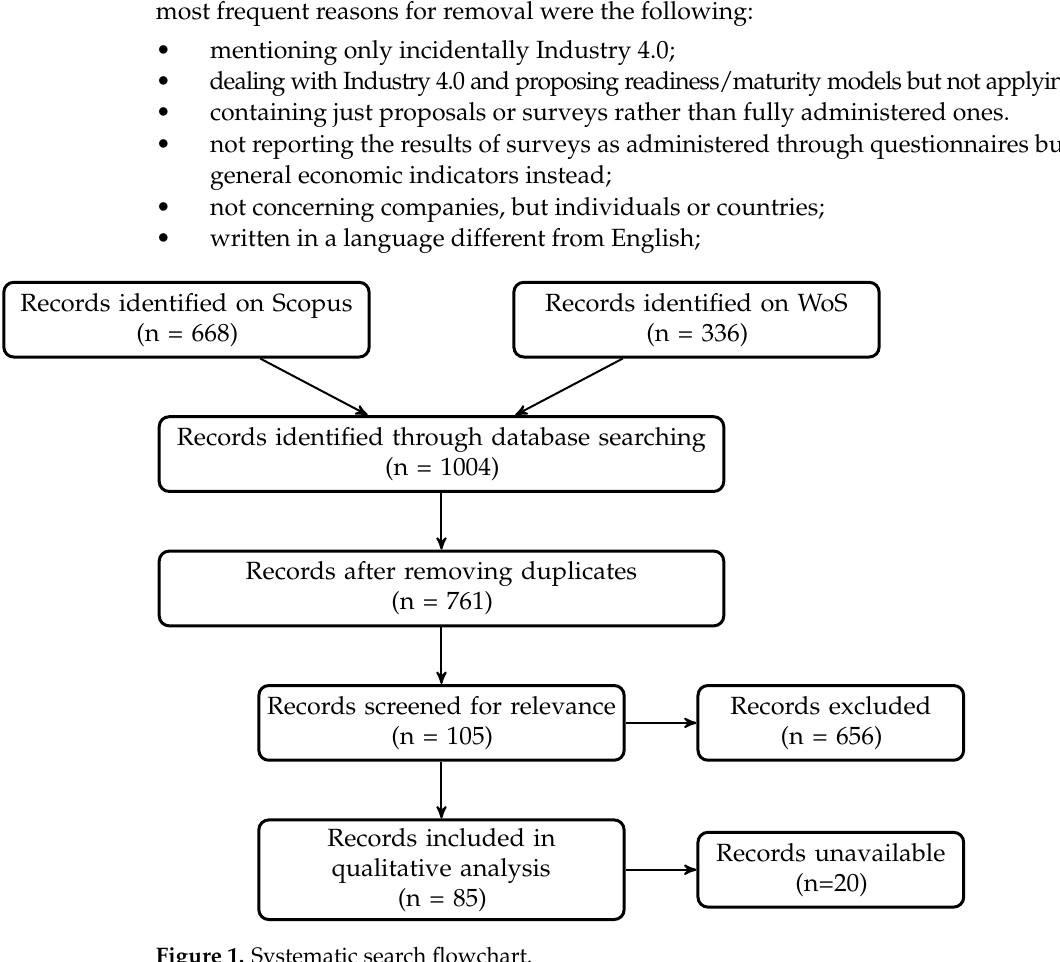
Figure 1. Systematic search